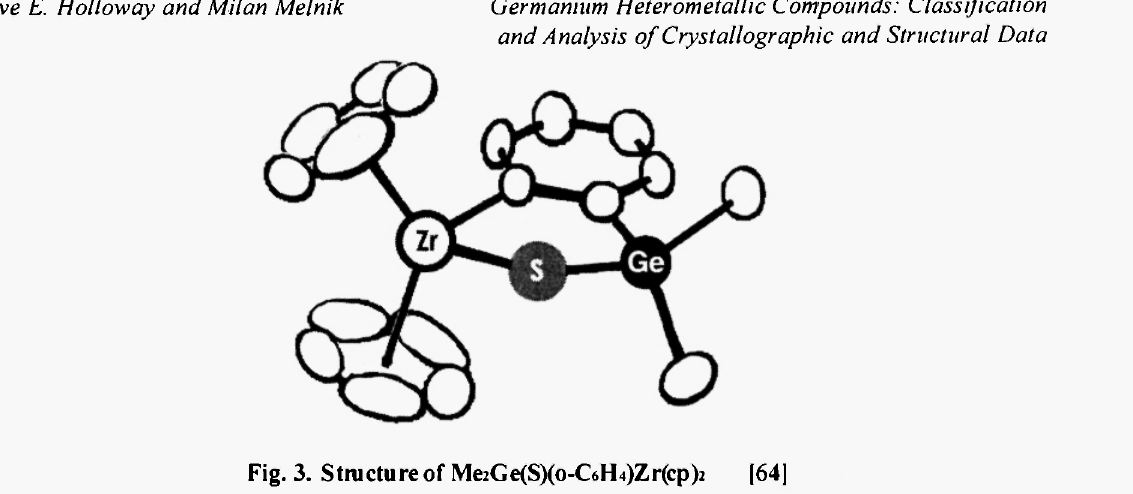
Fig. 3. Structure of Me 2 Ge(S)(o-C6H4)Zr(cp)2